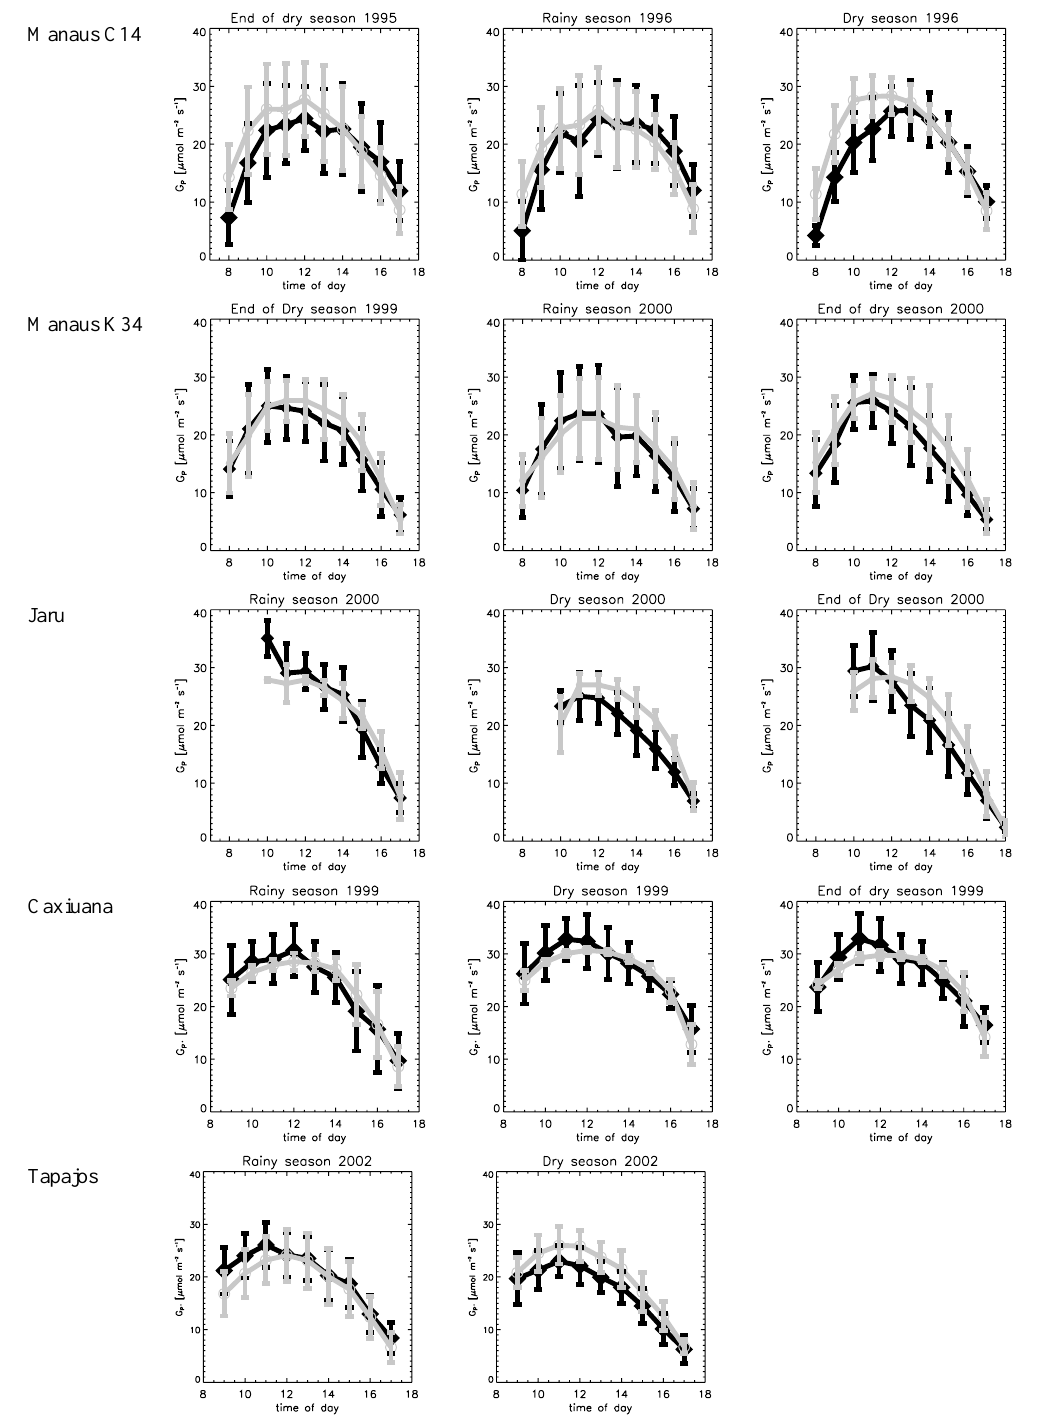
Fig. 3. Diurnal cycle of observed (black) and simulated (grey) G P